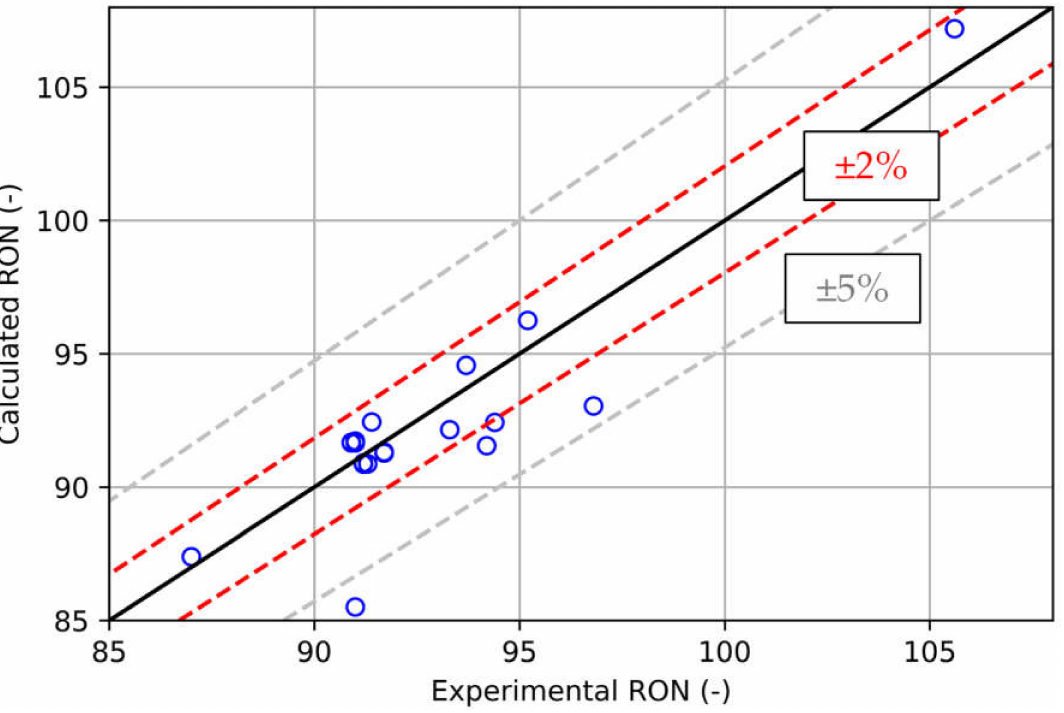
Figure 4. Parity plot for the RON calculated by means for the blending rule against